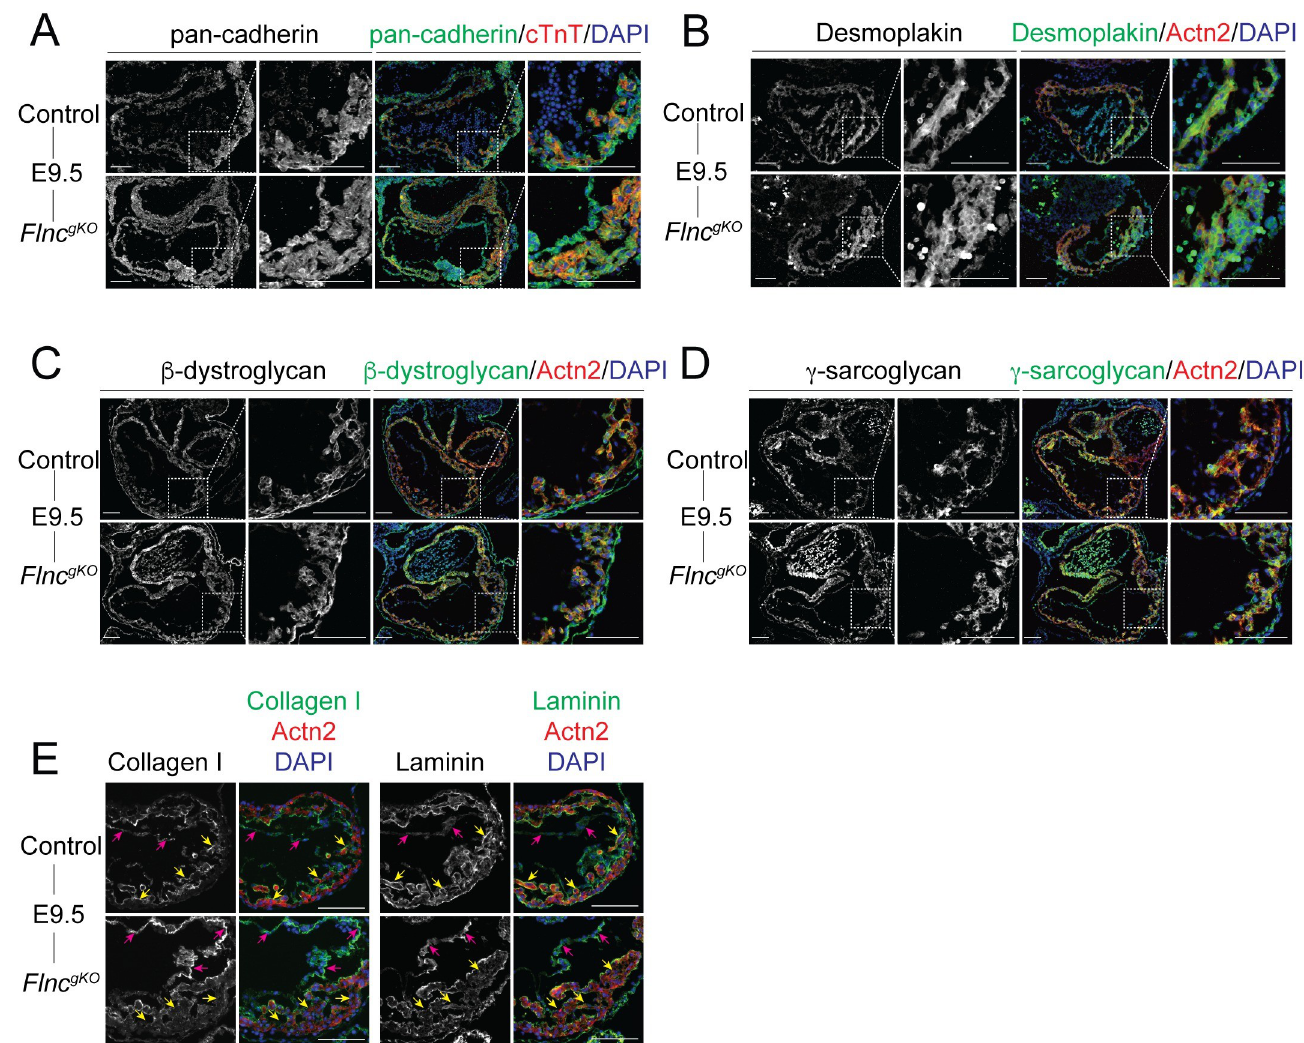
Fig 4. Extracellular matrix proteins are downregulated in the myocardium of Flnc gKO . ( A-D ) Representative immunofluorescence (IF) images of control and Flnc gKO hearts at E9.5 using antibodies against α -actinin (actn2) or cardiac troponin T (cTnT), and pan-cadherin ( A ), desmoplakin ( B ), β -dystroglycan ( C ) or γ - sarcoglycan ( D ). Scale bar, 0.1 mm. ( E ) Representative collagen I and laminin immunofluorescence images of control and Flnc gKO hearts at E9.5. yellow arrows: myocardium; magenta arrows: endocardium. Scale bar, 0.1